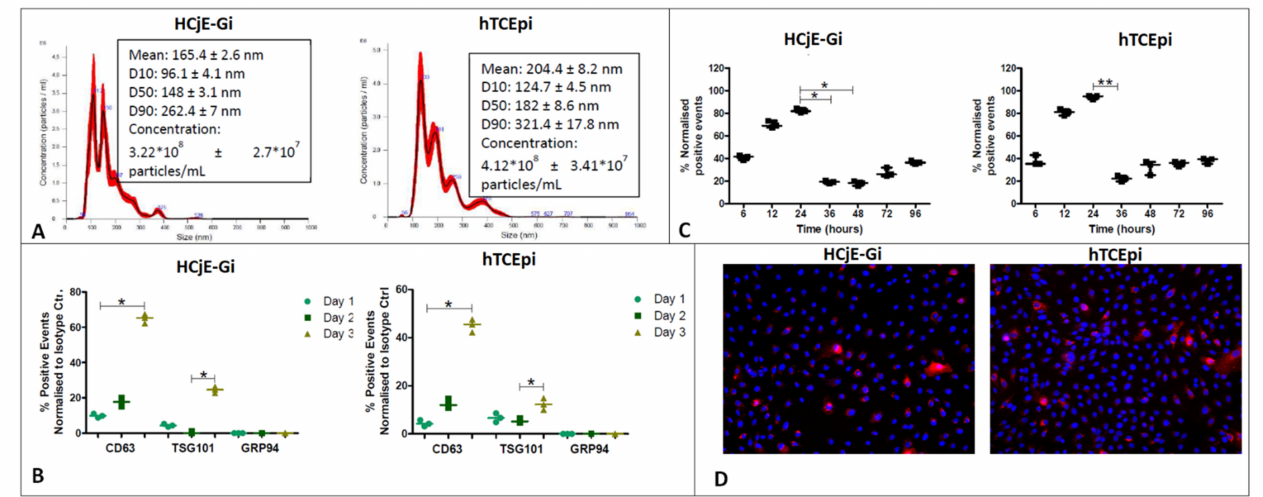
Figure 2. Characterization and internalization of the EVs from both the cell types. ( A ) Size distribution and particle concentration of the extracted EVs from conditioned medium obtained after culturing the cells for three days as assessed by NanoSight. The percentage undersize is indicated by D10, D50, and D90. ( B ) Characterization using flow cytometry analysis showing the percentage of positive events that are normalized against its isotype control. ( C ) Internalization and/or docking profiles of XenoLight DiR labelled exosomes of hTCEpi cell-derived exosomes by HCjE-Gi cells and HCjE-Gi cell-derived exosomes by hTCEpi cells. Results are normalized against non-labelled exosomes (Data is represented as median ± range, n = 3, Kruskal–Wallis test followed by Dunn’s Multiple Comparison test, * p < 0.05, ** p < 0.01). ( D ) The presence of exosomes in the samples was observed following the DiL labeling on HCjE-Gi and hTCEpi cells. Dil labelled exosomes—red; nuclei stained with